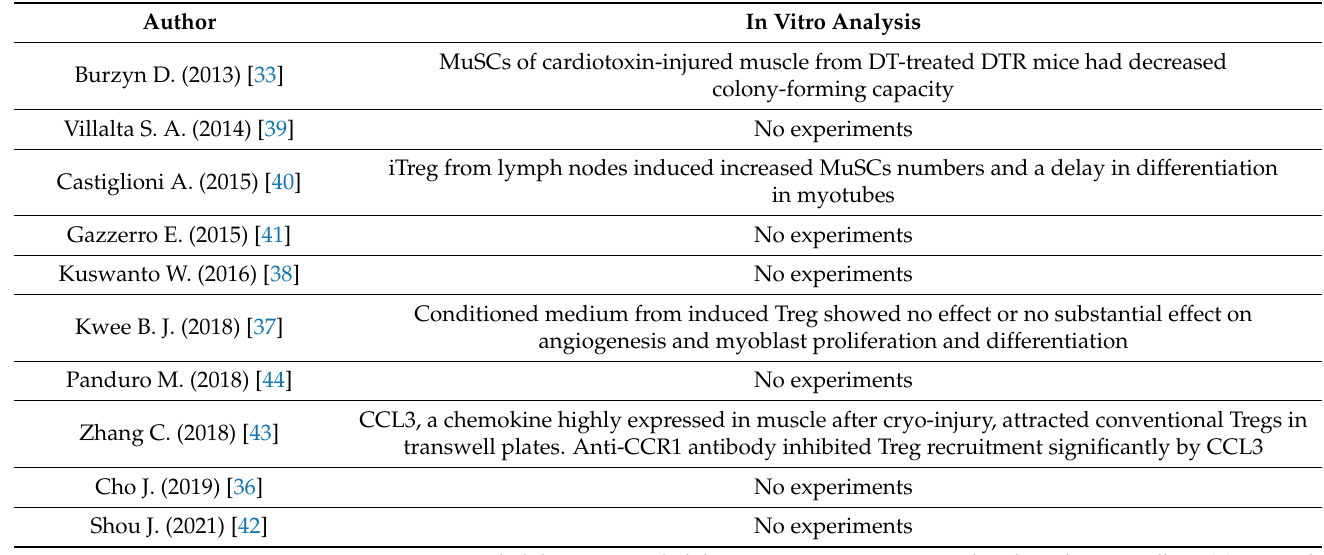
Table 4. In vitro experiments showing Treg functions related to skeletal muscle